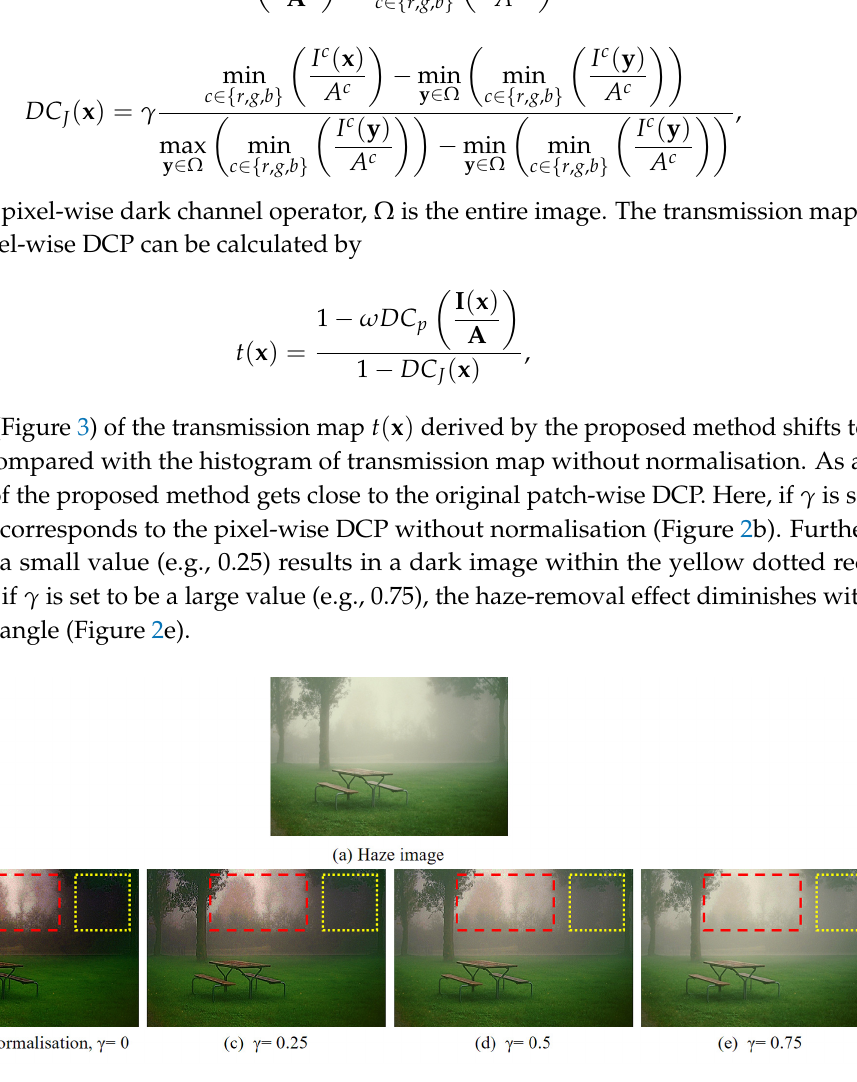
Figure 2. Differences among haze-removal images with each normalisation parameter γ